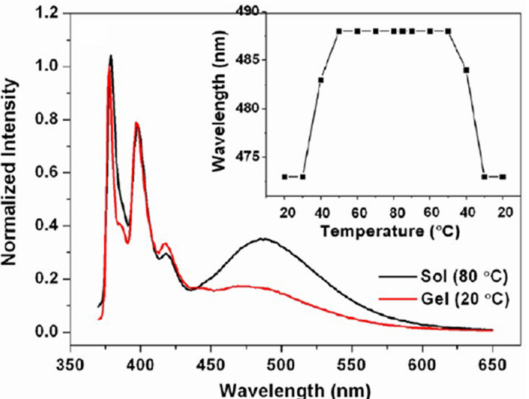
Figure 2. Fluorescence spectra ( λ ex = 350 nm; intensity normalized at 378 nm) of 1.5% (2.6 × 10 − 2 M) PySaG 7 in acetonitrile in the gel (20 ◦ C) and sol (80 ◦ C; gel melting temperature, T gel = 79 ◦ C) phases. The inset shows the temperature-dependent wavelength maxima of the excimeric emission. Reprinted (adapted) with permission from [39]. Copyright (2013) American Chemical